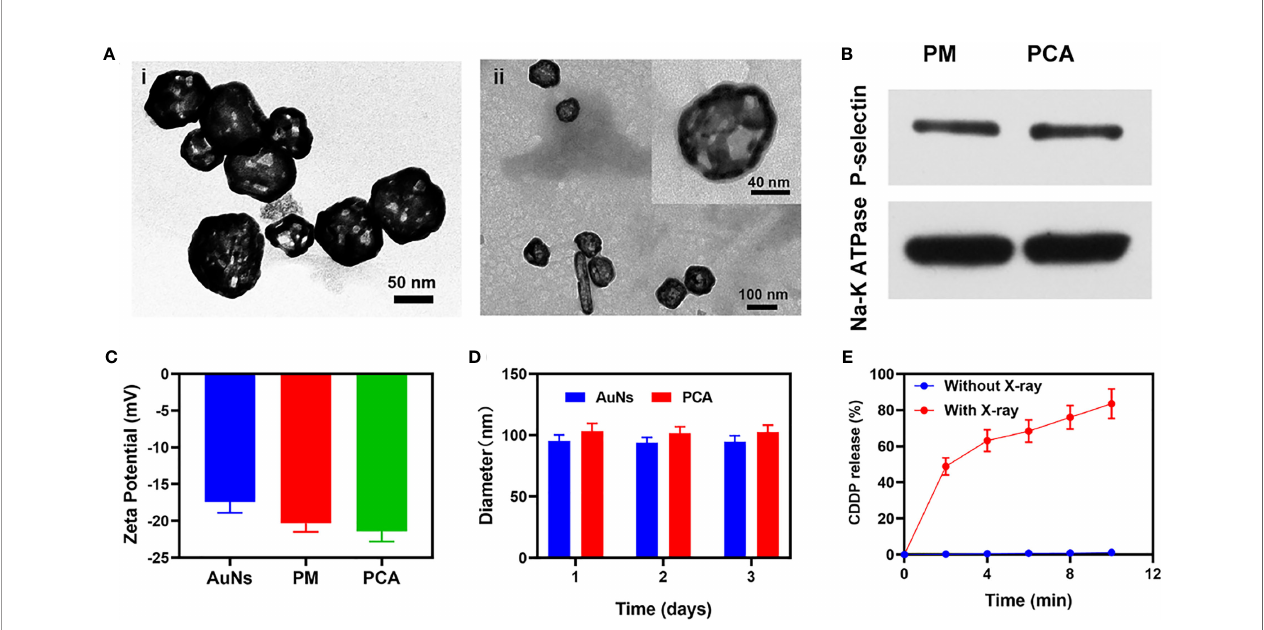
FIGURE 1 | (A) TEM image of (i) AuNs and (ii) PCA. Insert: single PCA with high magni fi cation. (B) The expressions of the key protein P-selectin on PCA with PM as a control. (C) Zeta potential of AuNs, PM, and PCA. (D) Statistical graph of the measured diameter of AuNs and PCA. (E) CDDP release pro fi les under different